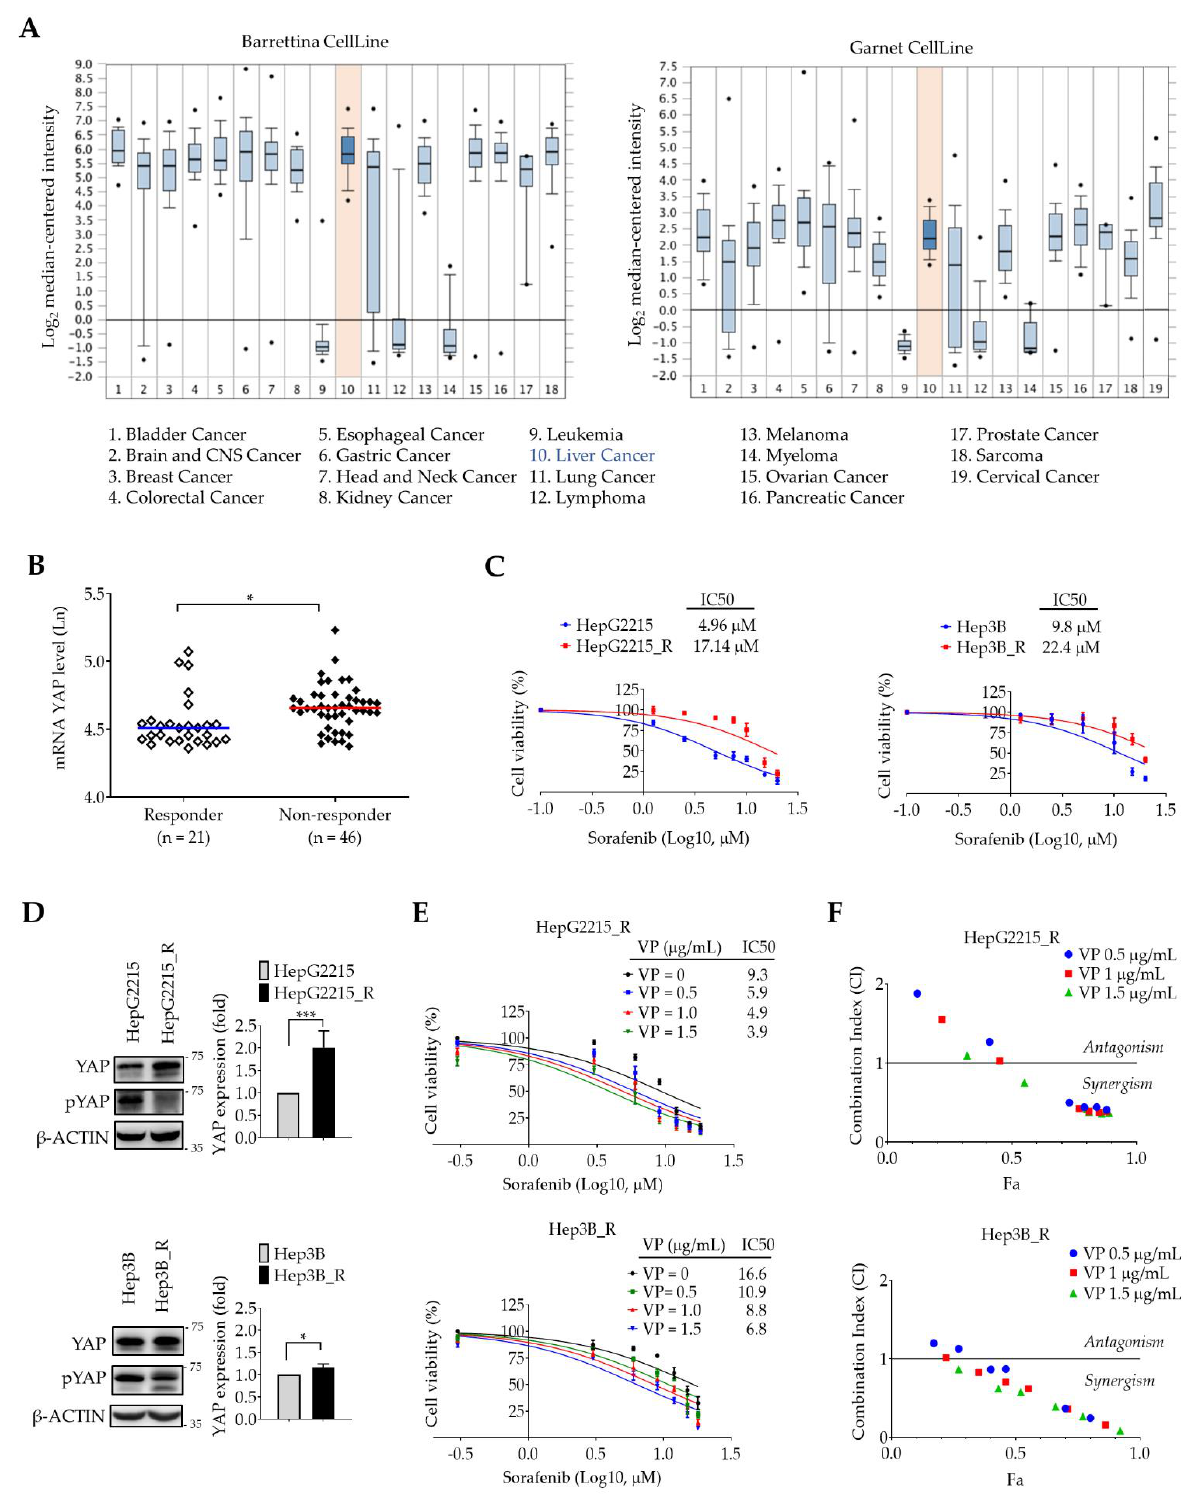
Figure 1. High expression of Yes-associated protein (YAP) correlates with sorafenib-resistant properties of hepatocellular carcinomas (HCCs). ( A ) mRNA expression levels of YAP in various cancer cell lines. Note the increase in YAP in liver cancer, from the Barretina CellLine database (3.6-fold, p = 1.22 × 10 − 15 , left panel) and the Garnet CellLine database (2.1-fold, p = 1.27 × 10 − 5 , right panel) through the ONCOMINE web server. Cancer types in the Barretina CellLine database are labeled 1–18, n = 917, Student’s t -test, and those in the Garnet CellLine database are labeled 1–19, n = 732, Student’s t